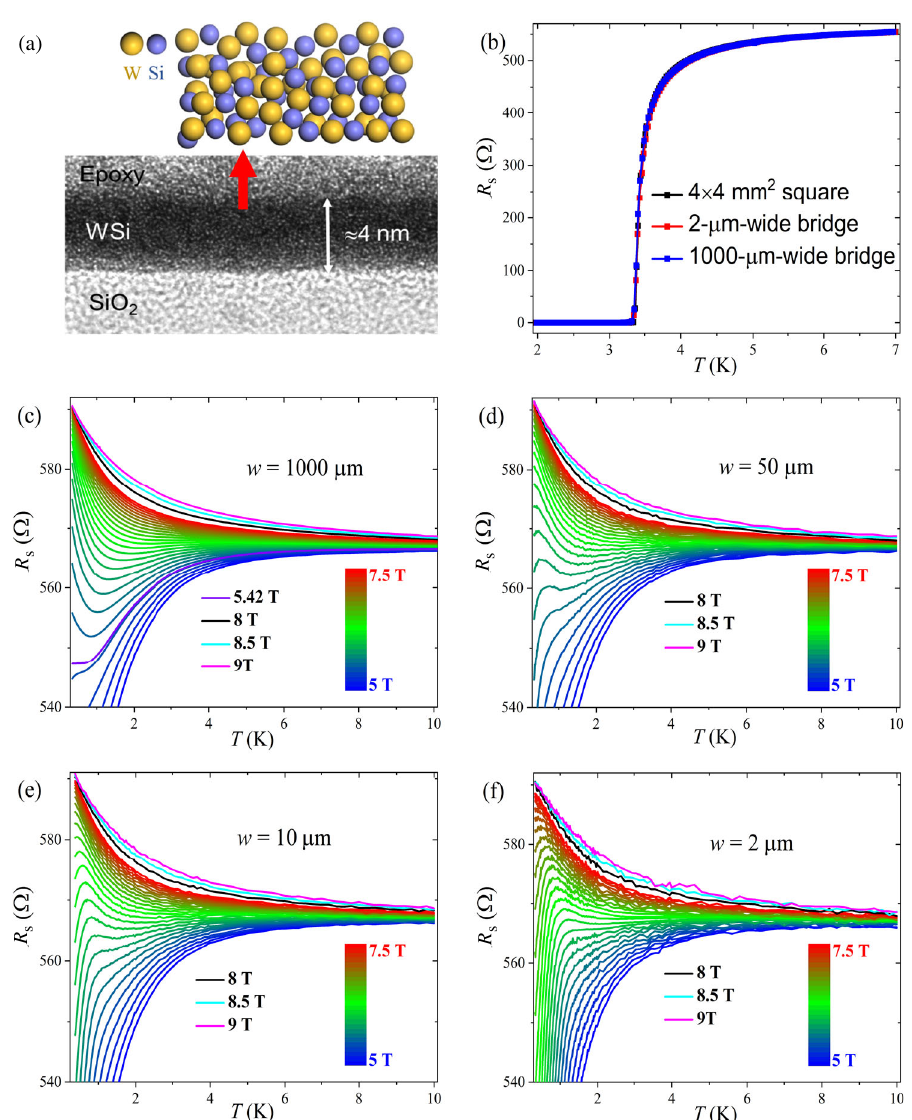
Fig. 1 Superconductor-to-insulator quantum phase transitions. a Schematic view of the amorphous WSi fi lms. The amorphous nature and the thickness are examined by cross-sectional transmission electron microscopy. b Zero- fi eld normal-to-superconductor transitions of the bare fi lms and the microbridges. c Sheet resistance R s T ð Þ as a function of temperature T in magnetic fi elds from B = 5 to 9 T of the 1000 µ m-wide bridge. The violet line shows the separatrix at the quantum critical fi eld B 1 for the superconductor-to-Bose insulator quantum phase transition. d – f Corresponding R s T ð Þ data of the 50, c 10, and the 2 µ m-wide bridges, T ð Þ of 50, 10, and 2 µm-wide bridges in Figure 1d – f show the R s the same fi eld range as in Fig. 1c for the 1000 µm-wide bridge, demonstrating that the SIT is completely different from that in T ð Þ the in fi nite 2D systems. Distinct from the SIT in Fig. 1c, the R s in the zero-temperature limit drop dramatically with decreasing temperature. The complete evolution of the SIT as a function of bridge width is shown in the Supplementary Fig. 1 and in Supplementary Movie 1. The corresponding phase boundaries are well separated by a fi nite-temperature maximum T on the max R ð T Þ curves (open red circles) and the dR ð T Þ = dT changes its s s ð T Þ (Fig. 2b). With sign at a characteristic critical fi eld B * max c